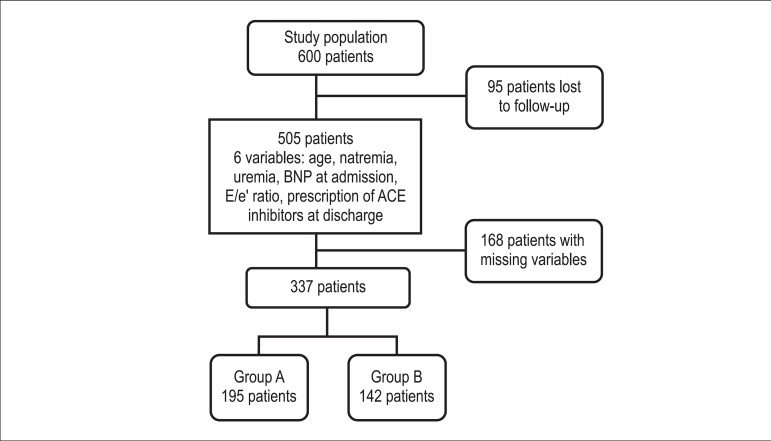
Diagram of study design with number of patients and number of
variables.